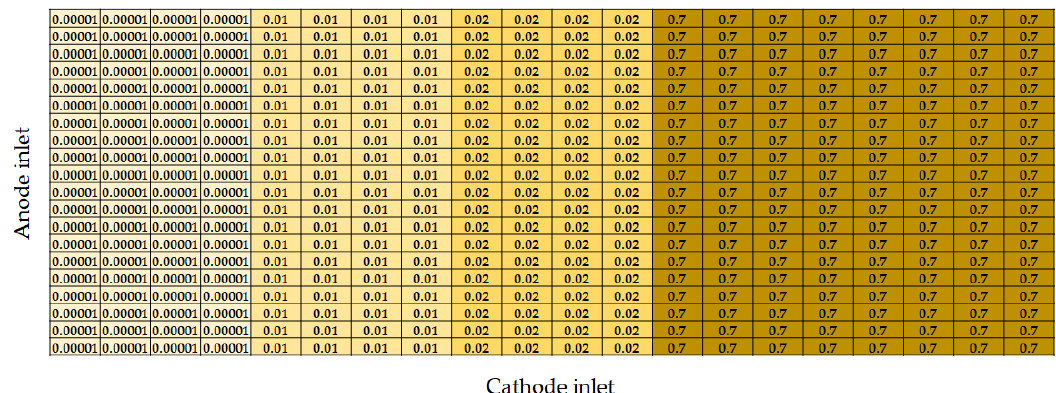
Figure 2. Matrix of σ to consider the active area reduction due to deactivation processes, such as carbon deposition and poisoning effect.